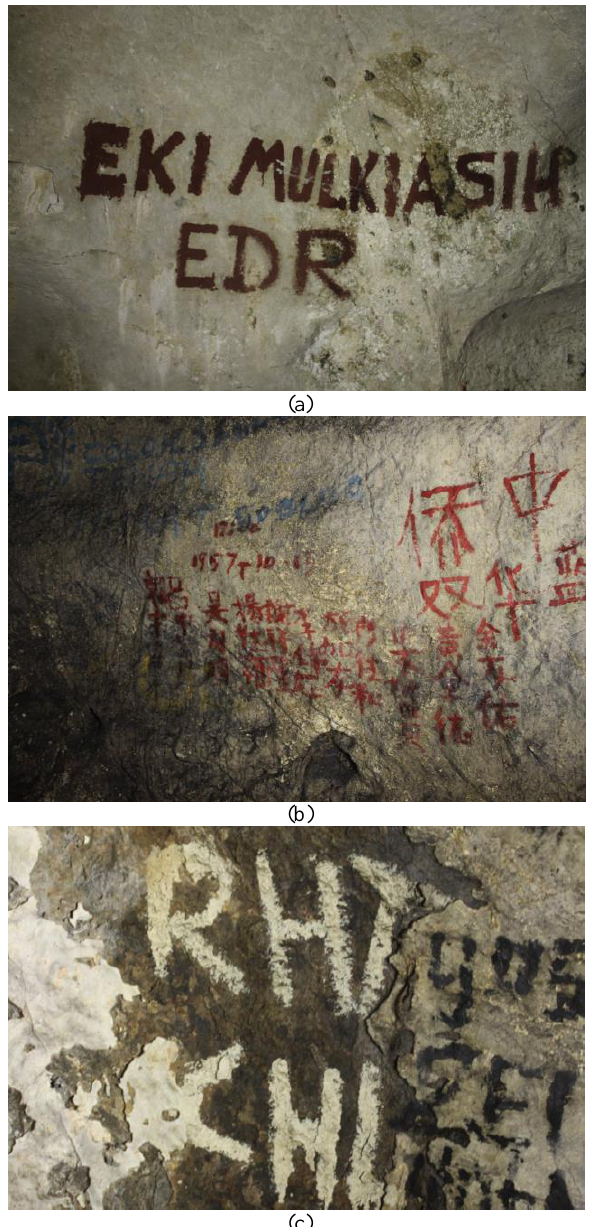
Figure 1 . Grafitti from the three locations (a) case 1, (b) case 2, and (c) case 3, which were used in this study.